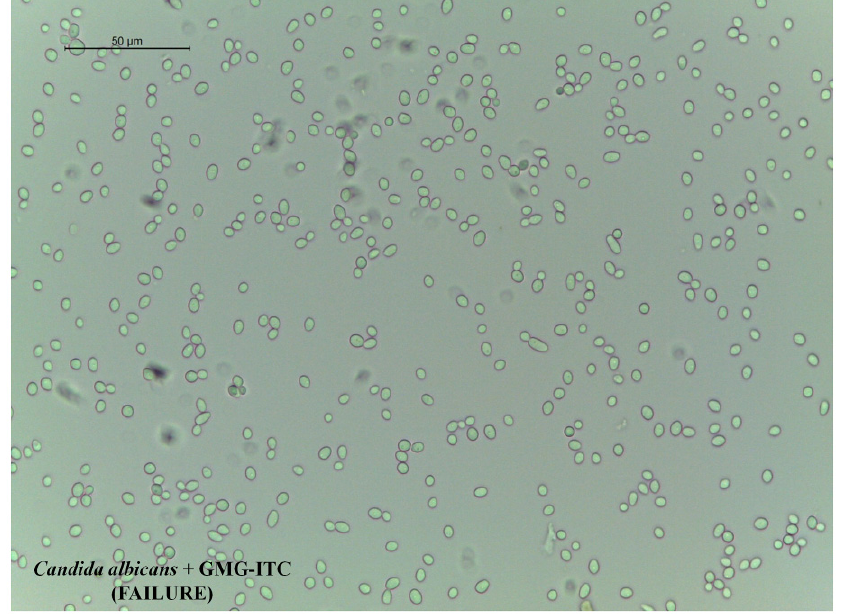
Figure 3. C. albicans resistance to GMG-ITC treatment. Studies performed to assess C. albicans sensibility to GMG-ITC reveal that the molecule does not have any effect on this yeast. In the figure, the failure of the treatment has been reported. Image was taken using a 40× objective, scale bar = 50